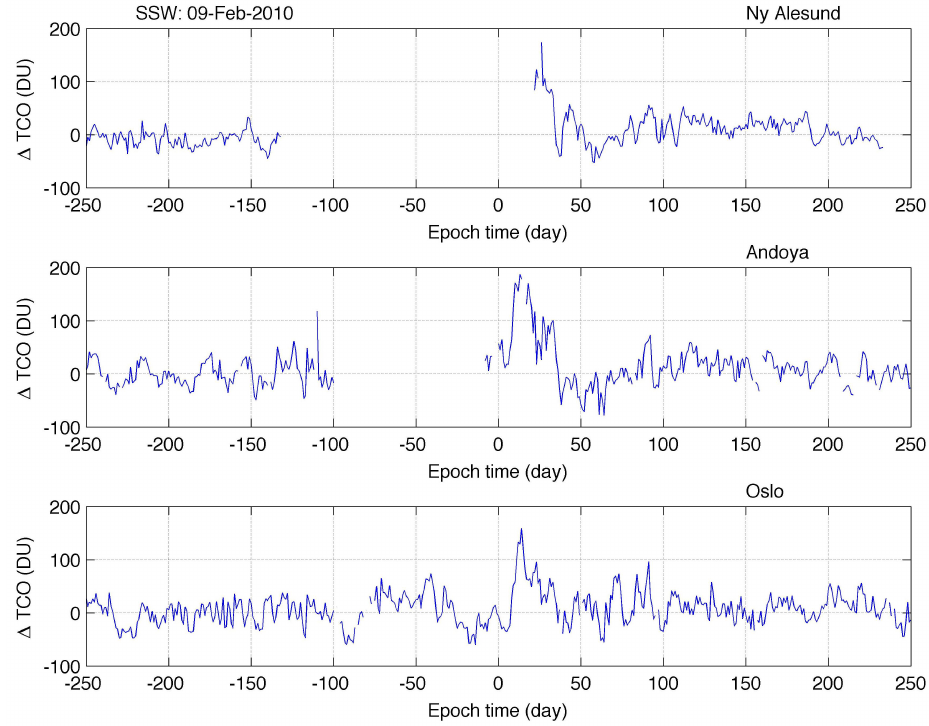
Figure 1. Anomalies in TCO with respect to the climatology observed at Ny Ålesund, Andøya and Oslo (GBcomb dataset). Epoch time 0 corresponds to the central date of 9 February 2010 for the major SSW. Data gaps are due to observations not being obtained in the polar